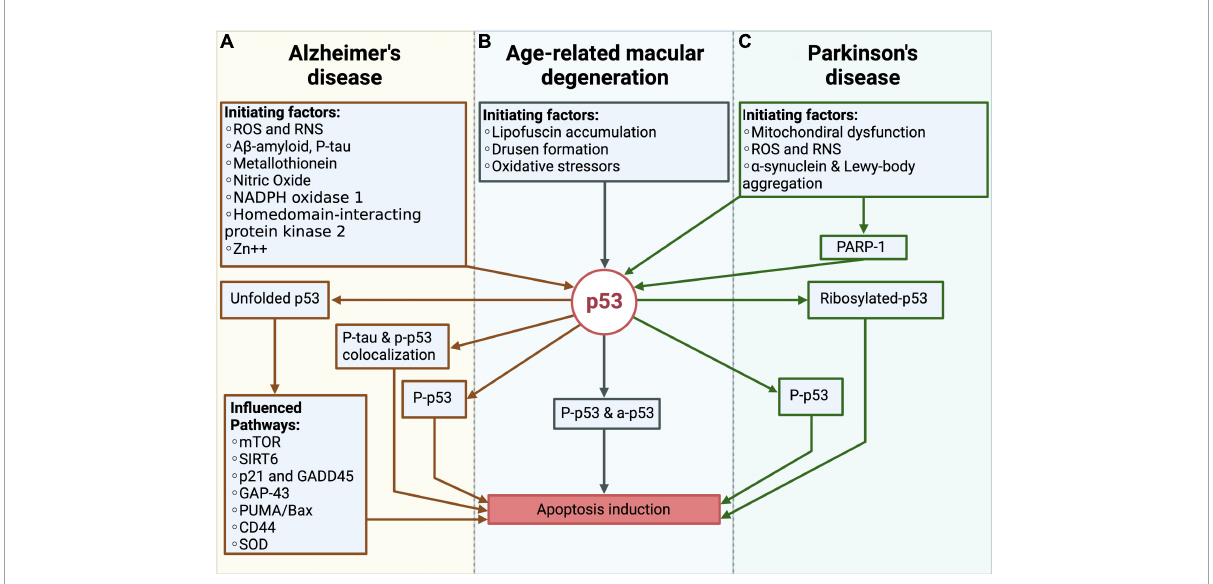
FIGURE5 Overview over the role of p53 in Alzheimer’s disease (AD), Parkinson’s disease (PD) and the age-related macular degeneration (AMD). (A) In AD, different pathogenic factors like e.g., reactive oxygen species (ROS) and reactive nitrogen species (RNS), A β or p-tau, promotes the formation of unfolded p53, phosphorlyated-p53 (p-p53) as well as the colocalization of the tau protein and p-p53. Through these changes, the apoptosis of neurons is induced. (B) In AMD, the lipofuscin accumulation and drusen formation as well as oxidative stressors like e.g., the blue light induced ROS formation, initiate phosphorylated and acetylated p53, which further leads to the cell death of RPE cells. (C) In PD, mitochondrial dysfunction, ROS production and the accumulation of pathogenic proteins like α -synuclein and Lewy-bodies influence p53. Together with PARP-1 these factors promote the ribosylation and phosphorylation of p53, which is responsible for the cell death of dopaminergic